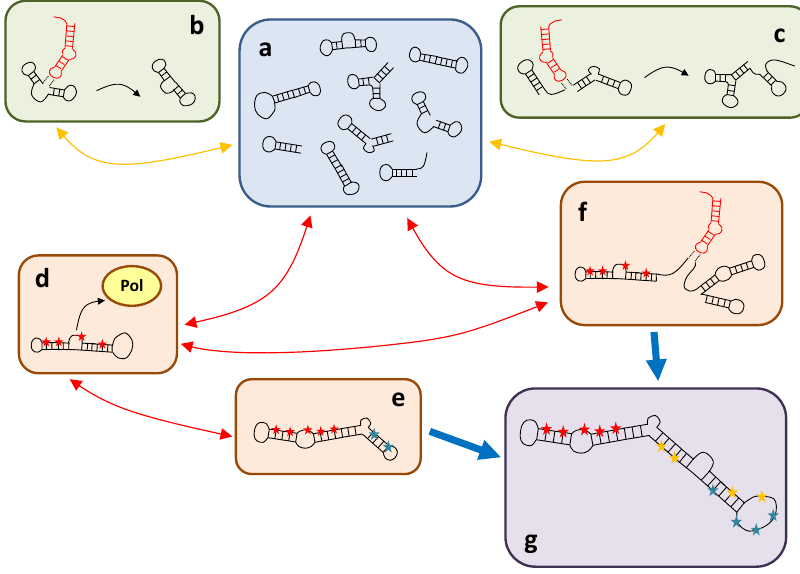
Figure 4. Schematics of a parsimonious scenario leading to the emergence of viroid-like replicons de novo. Structures in black represent circulating RNAs with various structures and functions; structures in red stand for hairpins with RNA ligase activity; stars indicate positions in the sequence that are fixed, different colors corresponding to possible motifs that interact with different